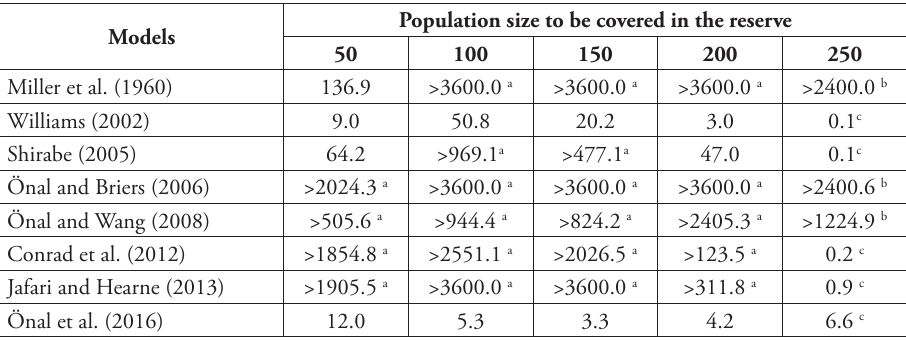
Table 2. Computational efficiency of alternative contiguity models in solving a 100-site problem.